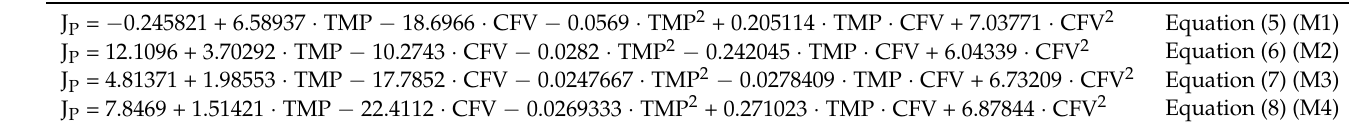
Table 5. Equations from the multiple regression statistical model for Jp (total recycle mode).